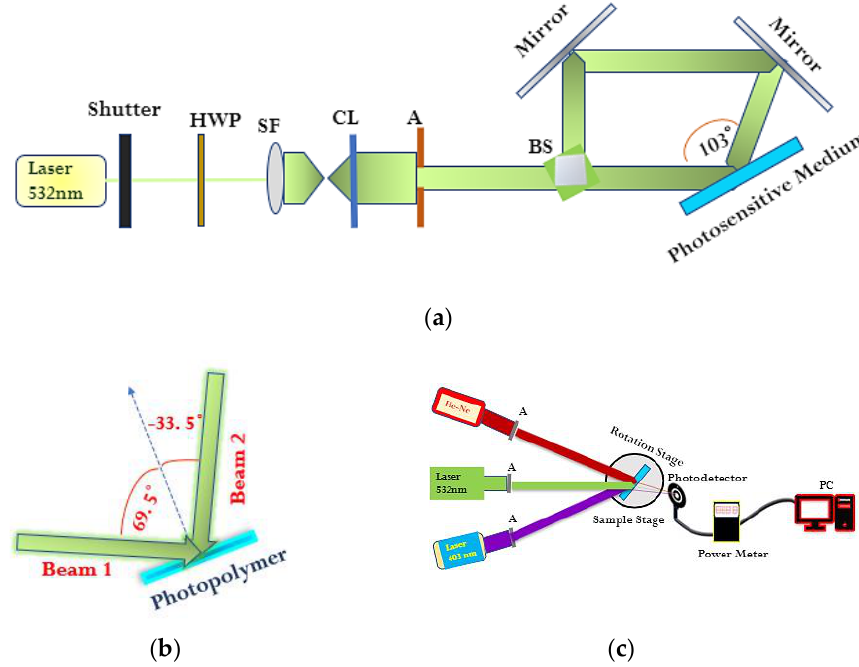
Figure 8. ( a ) Recording setup. ( b ) Recording beam angles of incidence on the photopolymer. ( c ) Reconstruction setup.